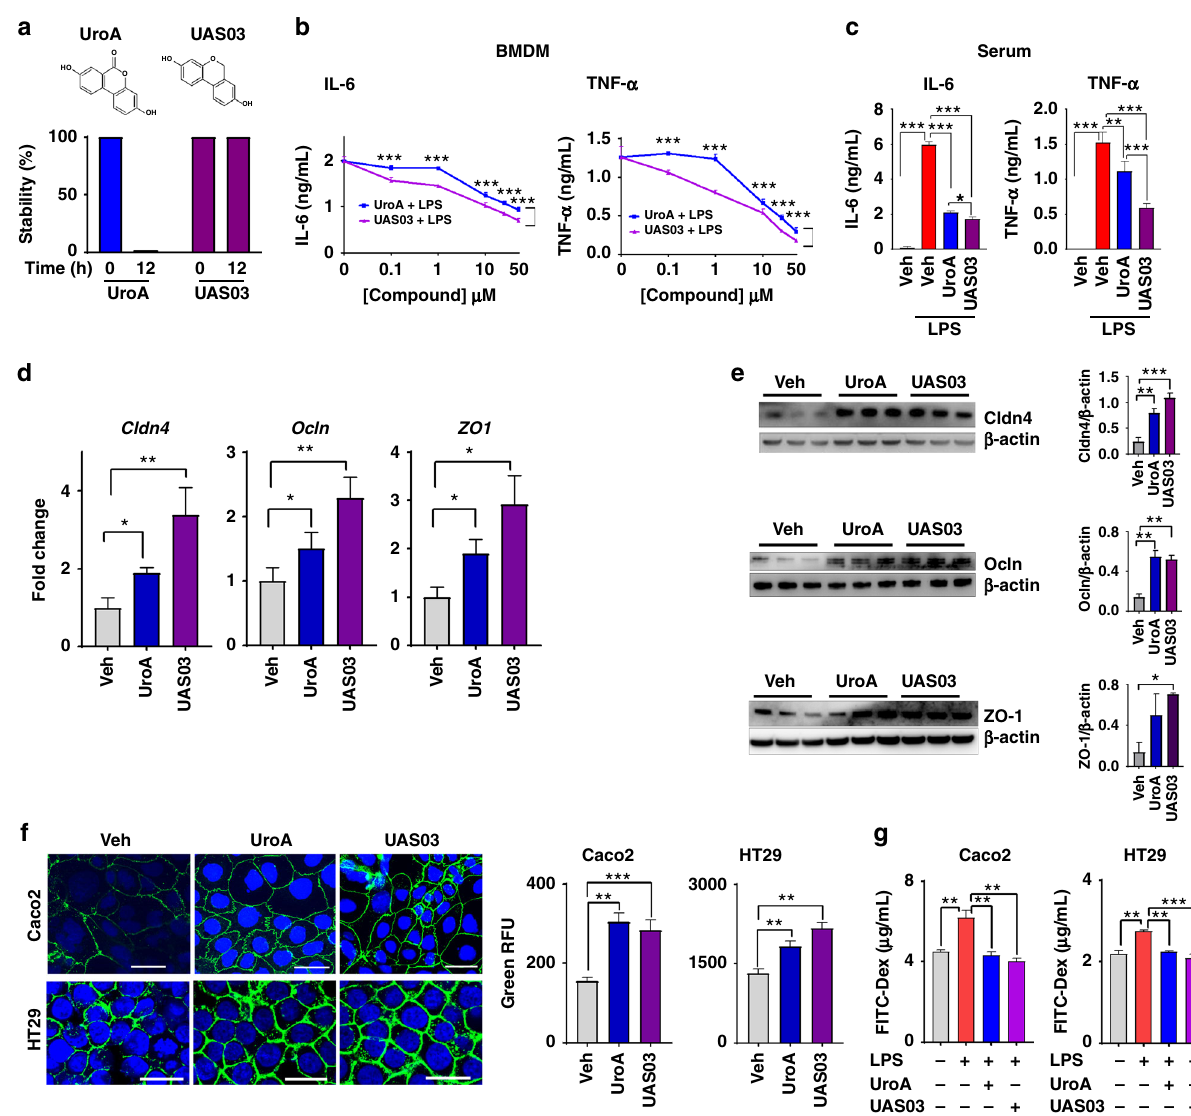
Fig. 1 UAS03 is a potent anti-in fl ammatory structural analogue of UroA and induces tight junction proteins. a Chemical structures of UroA, UAS03. UroA/ UAS03 stability was examined in the presence of gastric pH 2.0 and digestive enzymes. UroA and UAS03 (0.2 mg/ml) were incubated with digestive enzymes (esterases and proteases, 100 U/ml) for 12 h at 37 °C and compound levels were quanti fi ed. b BMDMs were stimulated with LPS (50 ng/ml) without or with UroA (blue line)/UAS03 (purple line) (0.1, 1, 10, 25, and 50 µ M) for 6 h. IL-6 and TNF- α levels in supernatants were measured. c C57BL/6 mice (n = 3 – 4) were pretreated with UroA (20 mg/kg) and UAS03 (20 mg/kg). After 4 h, LPS (2 mg/kg) was injected intraperitoneally. Post 4 h of LPS administration, serum levels of IL-6 and TNF- α was measured. d – f HT29 or Caco2 cells were treated with vehicle (DMSO-0.01%) or UroA/UAS03 (50 μ M) for 24 h. d The fold changes in mRNA levels of claudin 4 ( Cldn4 ), occludin ( Ocln ), and Zona occludens 1 ( ZO1 ) in HT29 cells were determined by RT PCR method. e UroA/UAS03 induced protein expression of Cldn4, Ocln, and ZO1 in HT29 cells were determined by immunoblots and quanti fi ed by Image J software. f Caco2 or HT29 cells were grown on coverslip bottom FluroDish and treated with Vehicle, UroA/UAS03 for 24 h. The cells were stained with anti-Cldn4 followed by secondary antibody tagged with Alexa-488. Nucleus was stained using DAPI. The confocal images were captured. The green intensity ( n = 15 – 20 cell membrane regions) was measured. Scale bars for Caco2 and HT29 cells indicate 50 and 25 μ m respectively. g Monolayer HT29 or Caco2 cells on transmembranes were treated with vehicle or UroA/UAS03 (50 μ M) for 24 h followed by treatment with LPS (50 ng/ml) for 2 h. FITC- dextran was added to these cells (top of the membrane) and incubated for 2 h and FITC-dextran levels in bottom chamber well was measured. Results are representative of three independent experiments with triplicates for each concentration. * p < 0.05, ** p < 0.01, *** p < 0.001, unpaired t -test between Veh, UroA, or UAS03. Error bars, ±SEM. Source Data are provided as a Source Data File signi fi cant increase in expression of the tight junction protein and another colon epithelial cell line, Caco2. Further, we observed Cldn4 in UroA treated cells. Although not statistically signi fi cant elevated expression of Cldn4 in the colons of mice treated with in our RNA-seq dataset, we further observed an increase in UroA/UAS03 (Supplementary Fig. 3a). The functional conse- expression of additional tight junction proteins ZO-1 and Ocln1 quence of increased tight junction proteins was examined using using real-time PCR (Fig. 1d). The increased levels of these in vitro FITC-dextran permeability assay in transwell plates. As proteins by UroA or UAS03 was con fi rmed by western blots shown in Fig. 1g, pretreatment of Caco2 or HT29 cells with (Fig. 1e) and Cldn4 by confocal imaging (Fig. 1f) in both HT29 UAS03 or UroA signi fi cantly inhibited LPS induced leakage of NATURE COMMUNICATIONS| (2019) 10:89